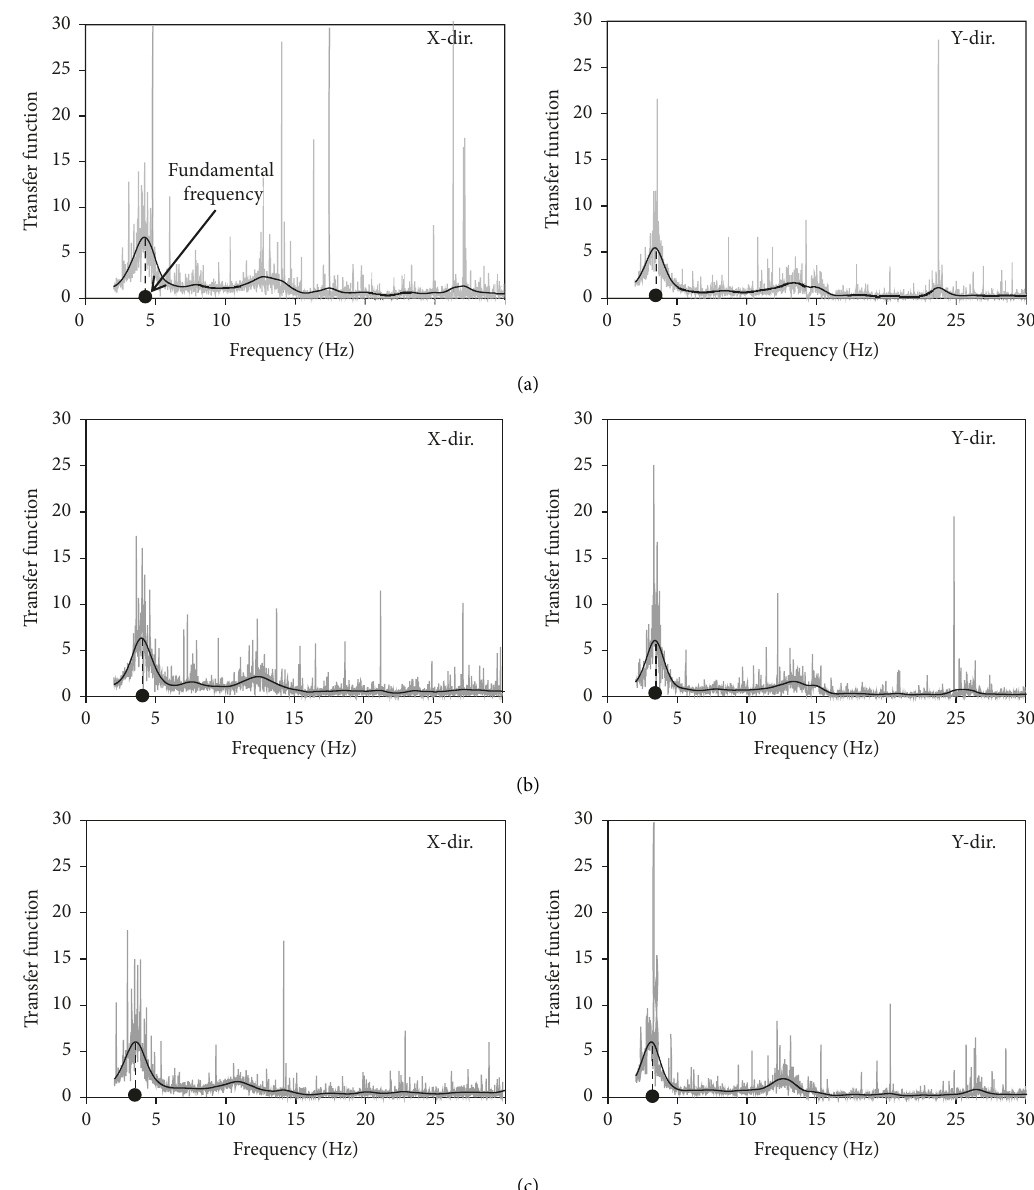
Figure 10: Transfer function-frequency curves at the top of the UPS specimens in Series B. (a) Test nos.1B–3B. (b) Test nos. 6B–8B. (c) Test nos.